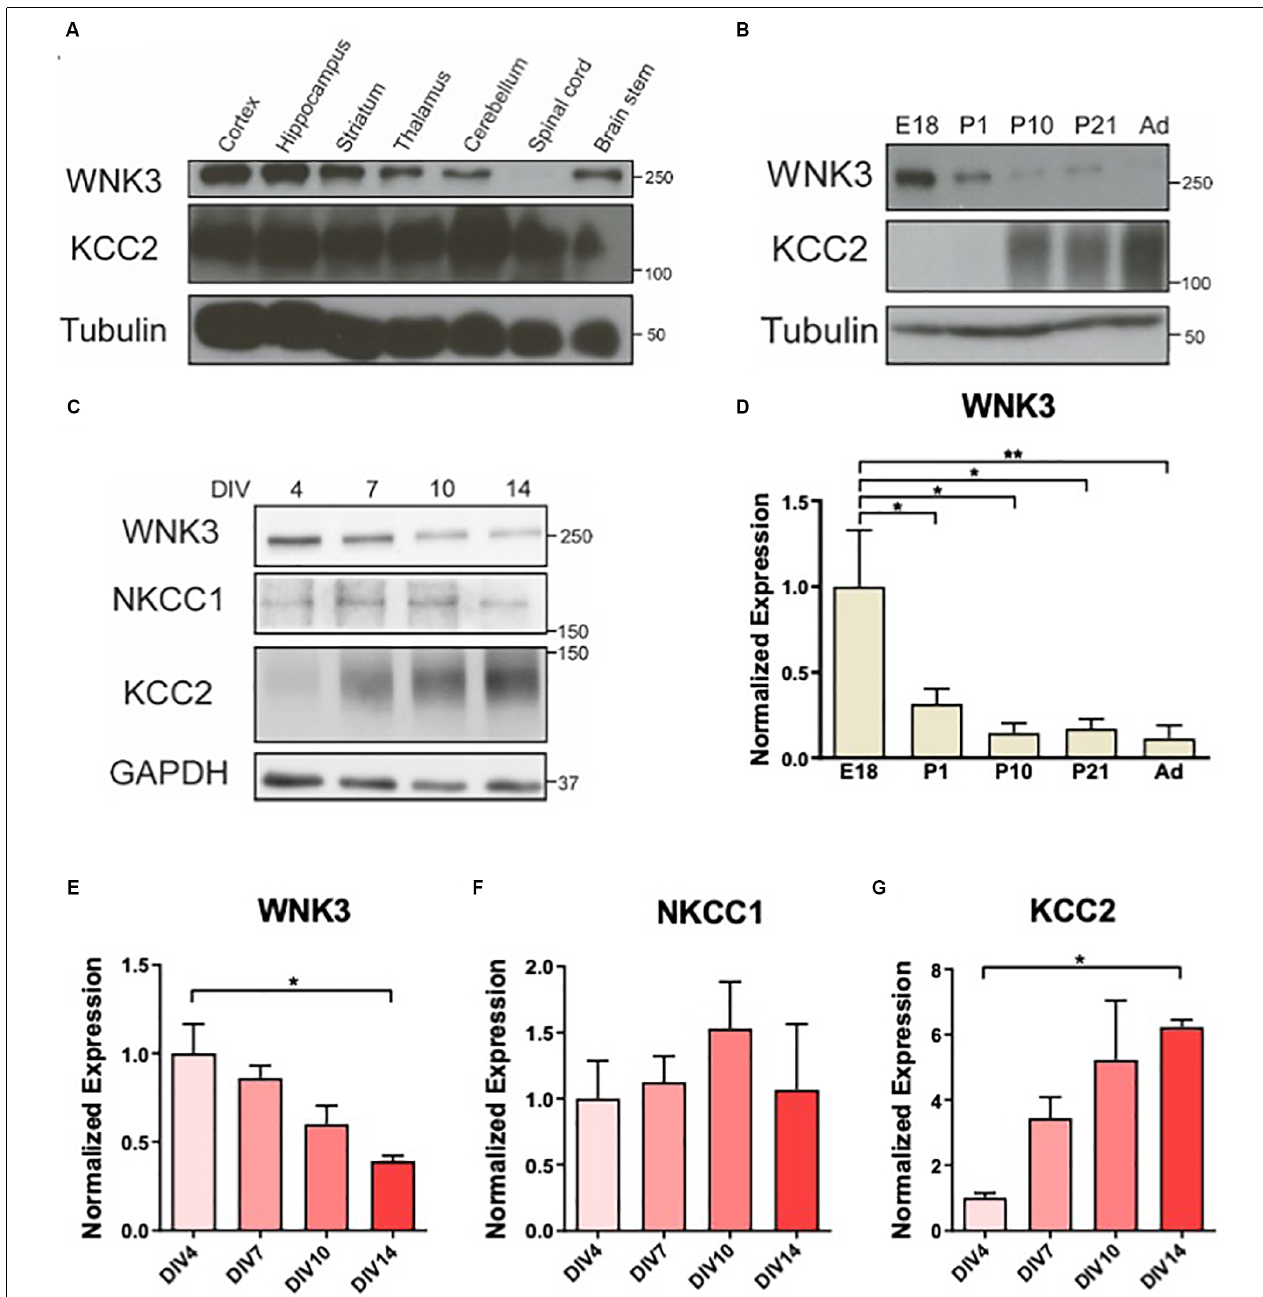
FIGURE 1 | Downregulation of WNK3 expression during maturation of cultured neurons. (A) Representative Western blots showing the expression of WNK3 and KCC2 in different CNS regions. (B) Representative Western blots showing the expression of WNK3 and KCC2 during the development of hippocampus. (C) Representative Western blots showing the expression of WNK3, NKCC1, and KCC2 in hippocampal neurons at different stages of culture. (D) Quantification of WNK3 protein expression from (B) , protein expression levels were normalized to their respective loading controls and expressed relative to E18 levels. n = 3 animals. * p < 0.05 and ** p < 0.01. One-way ANOVA with Bonferroni post-hoc . (E–G) Quantification of WNK3, NKCC1, and KCC2 protein expression from (C) . Protein expression levels were normalized to their respective loading controls and expressed relative to DIV4 levels. n = 3 cultures. * p < 0.05 and ** p < 0.01. One-way ANOVA with Bonferroni post-hoc